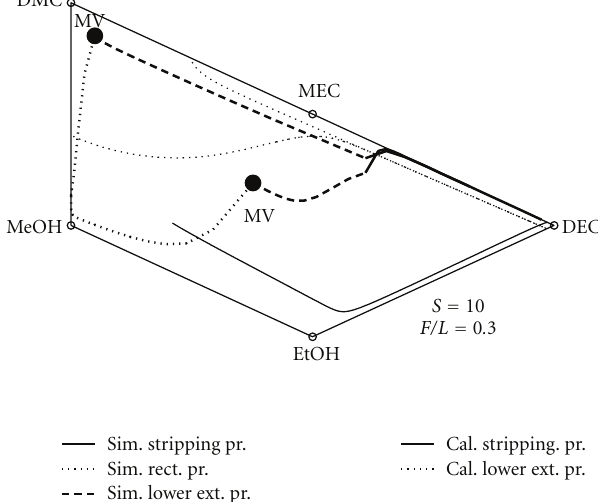
Figure 12: Simulated and calculated profiles at total reflux, at S = 10, and at F w /L = 0 .